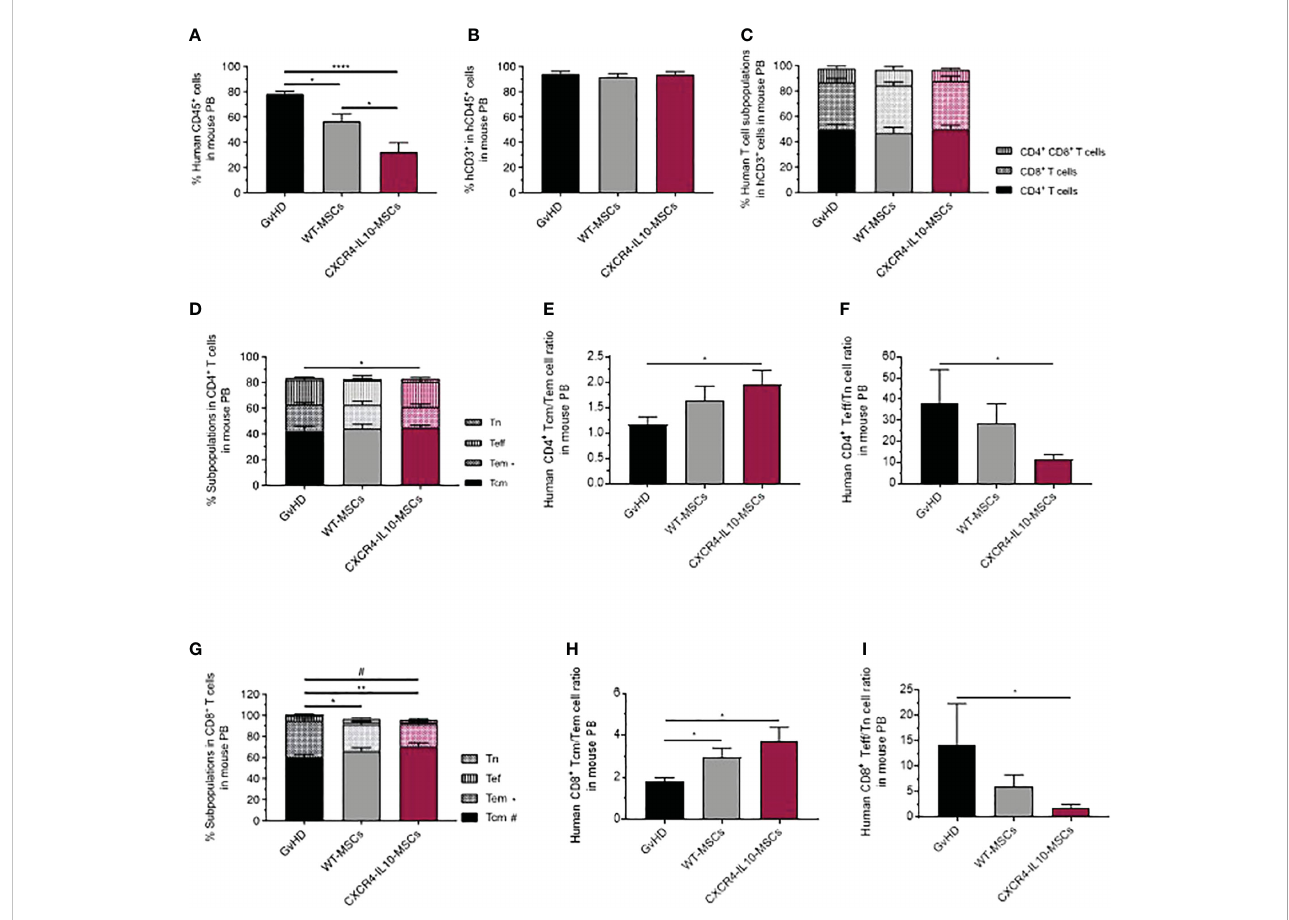
FIGURE 4 Analysis of peripheral blood human T cells in humanized GvHD recipient mice treated with WT-MSCs or CXCR4-IL10-MSCs. (A) Analysis of the proportion of hCD45+ cells present in PB of transplanted NSG recipients and treated with WT- or CXCR4-IL10-MSCs. (B) Proportion of hCD3+ cells present in PB hCD45+ cells corresponding to panel (A) . (C) Composition of PB hCD3+ T cells determined in each group of transplanted mice. (D) Frequency of naïve (Tn), effector (Tef), effector memory (Tem) and central memory (Tcm) subpopulations present in PB hCD4+. (E) Tcm:Tem ratio and (F) Tef:Tn ratio in PB hCD4+ cells. (G) Frequency of naïve (Tn), effector (Tef), effector memory (Tem) and central memory (Tcm) subpopulations present in PB hCD8+ T cells. (H) Tcm:Tem ratio and (I) Tef:Tn ratio in PB hCD8+ cells Analyses were performed 3 weeks after NSG mice transplantation. Each bar represents the mean ± SEM of data from fi ve experiments with NSG mice (n = 15-20 mice per group). *p < 0.05; **p < 0.01; ****p <